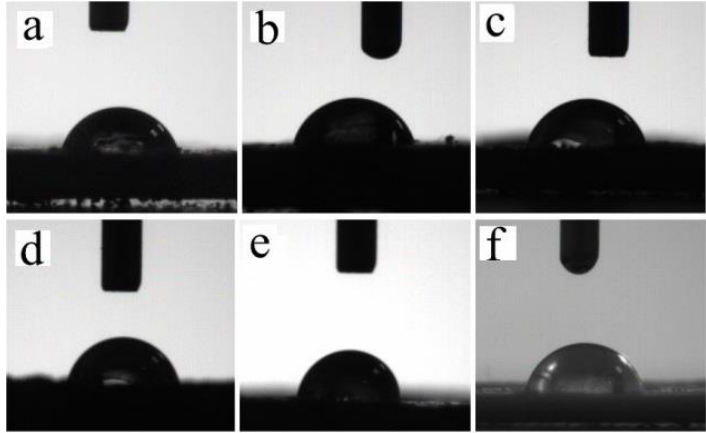
Figure 9. Water contact angles photographs of PLLA and sc-PLAG samples; the glucose content in the feeding of samples: ( a ) 5%; ( b ) 4%; ( c ) 2%; ( d ) 1%; ( e ) 0.5%; ( f ) PLLA. Table 4. Water contact angles of PLLA and sc-PLAG samples.